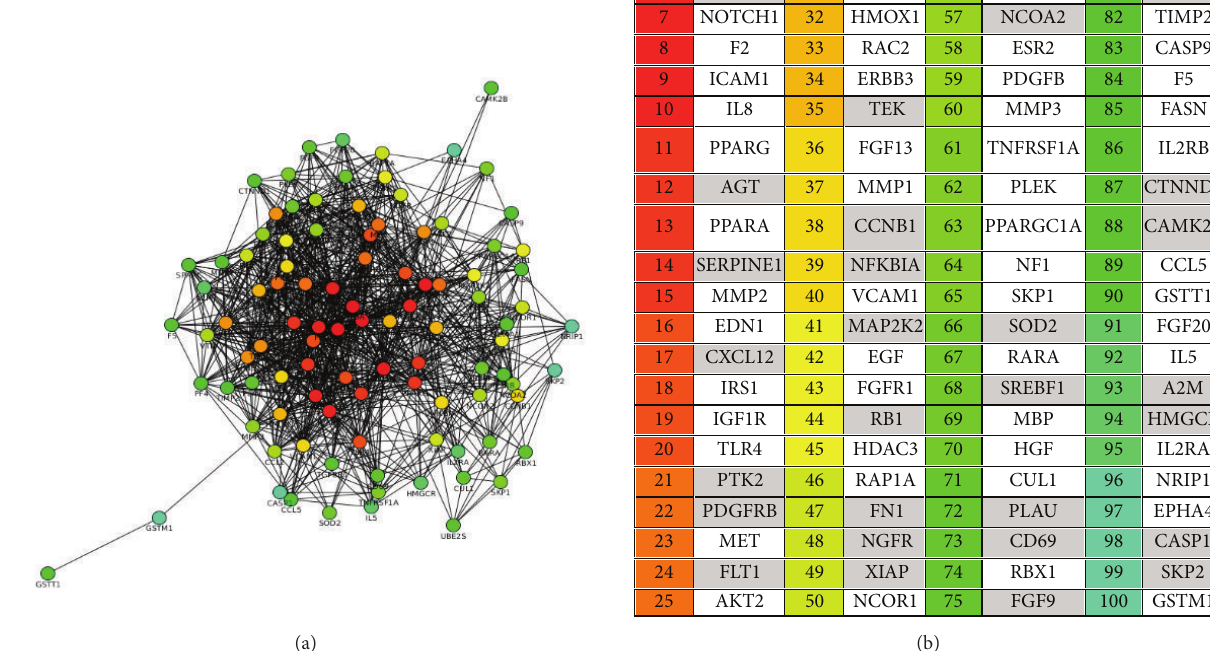
Figure4:(a)HubnetworkofKSOPsandputativecandidates.Theproteinsatthecentreofthenetworkaretheonesthatformmostinteractions with other proteins. (b) Hub proteins identified in the human neurological protein interaction network that includes newly identified gene products. The predicted gene candidates that are behaving as hubs have been